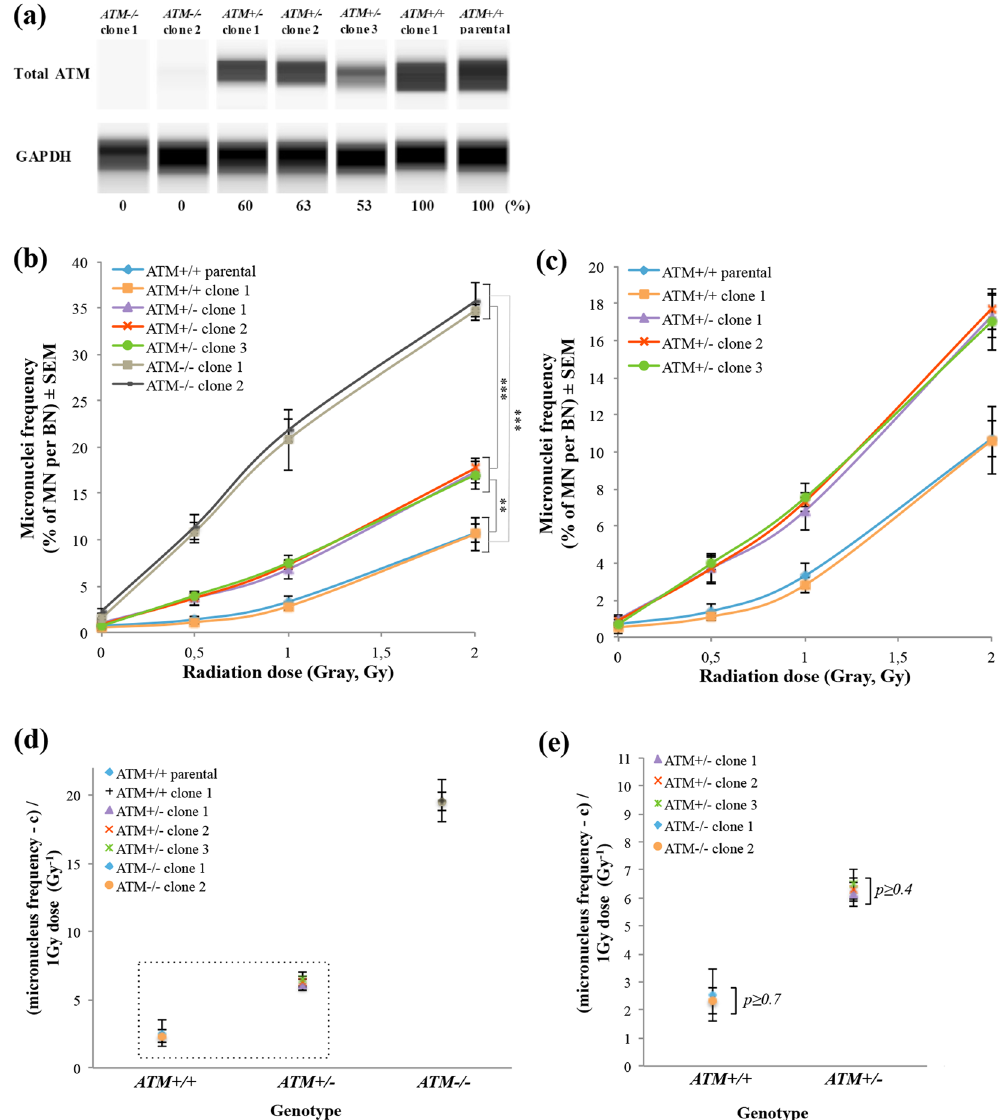
Figure 2. Screening approach for detecting the radiosensitivity of cells with a uniform genetic background. ( a ) Western blotting analysis data showing the expression levels of ATM protein in ATM -edited cell clones. The GAPDH antibody was used as a loading control. The intensity of ATM bands was normalized to that of GAPDH and is shown as a percentage relative to the score of ATM + / + cell clones set as 100%. ( b ) Percentage of IR-induced MN formation in ATM -edited cell clones (mean ± SE; t-test; *** p < 0.001, ** p < 0.01, * p < 0.05; n = 3; > 1000 BN cells, > 50 BN cells only in ATM − / − cell clones). ( c ) The graph from (b) with magnification of the Y-axis including the percentage of IR-induced MN formation in ATM + / − and ATM + / + cell clones. ( d ) Radiosensitivity in ATM -edited cell clones was quantified using the sum of α and β coefficients upon γ -ray irradiation at 1 Gy (mean ± SE; t-test; n = 3; > 1000 BN cells per experiment, > 50 BN cells per experiment only in ATM − / − cell clones). ATM − / − cell clones exhibited a remarkable radiosensitivity score. ( e ) The graph from (d) with magnification of the Y-axis including the radiosensitivity scores of ATM + / − and ATM + / + cell clones. Significant clonal differences in radiosensitivity were not detected (mean ± SE; t-test; values of p > 0.05 were not significant; n = 3; > 1000 BN cells per